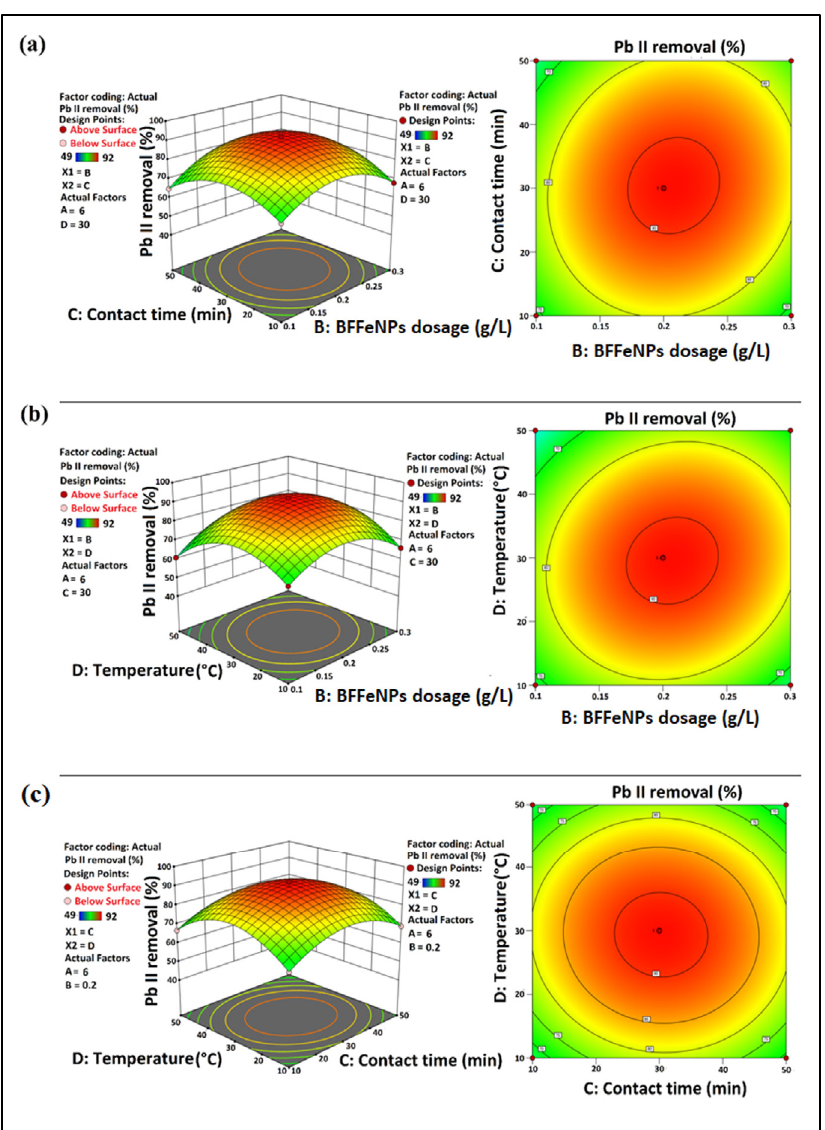
Fig. 6. Response surface 3D and contour plots showing the interactive effect between (a) BFFeNPs dosage and contact time (BC), (b) BFFeNPs dosage and temperature (BD) and (c) contact time and temperature (CD) during Pb (II)